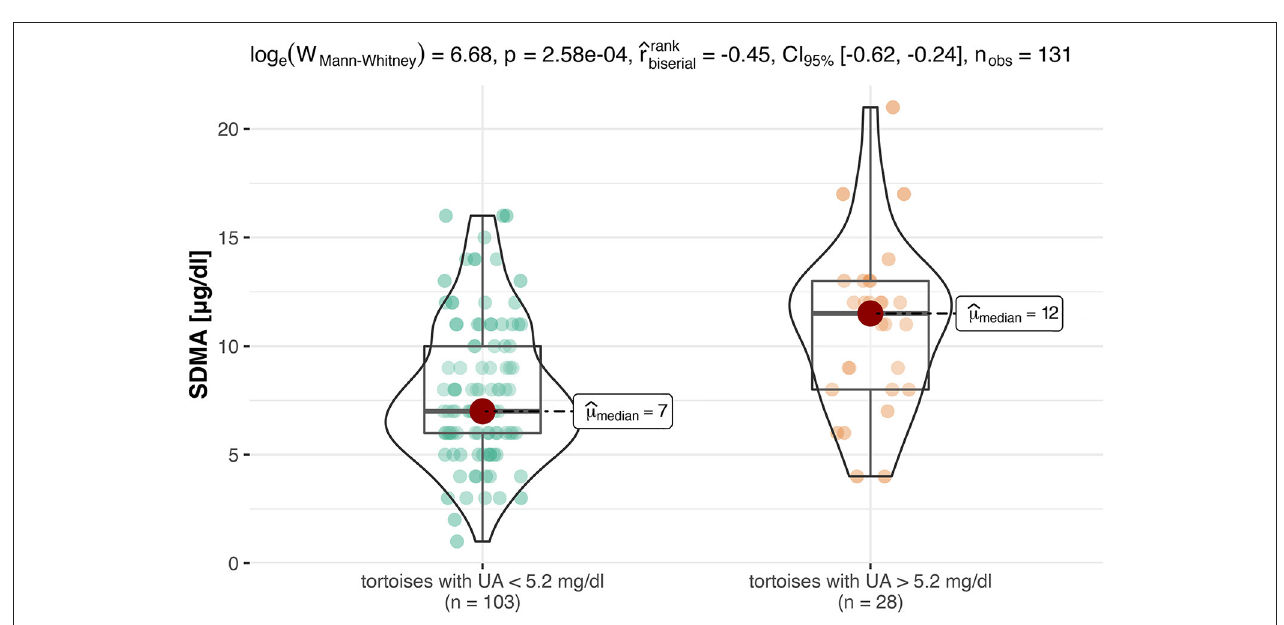
FIGURE 2 | This box-violin-plot shows the distribution of SDMA values after creating two groups based on UA values. The colored dots represent each individual data point, while the shape of the bean plot represents its density. In addition, the minimum and maximum values as well as the median are shown as